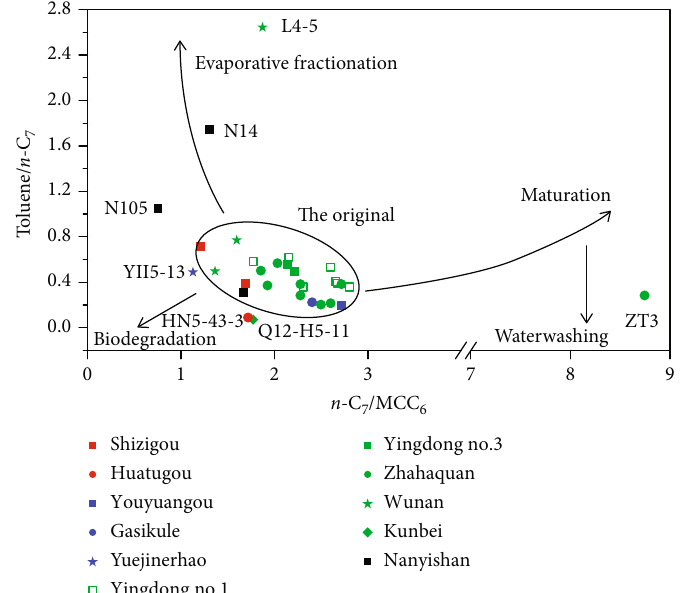
Figure 4: A cross plot of n -C